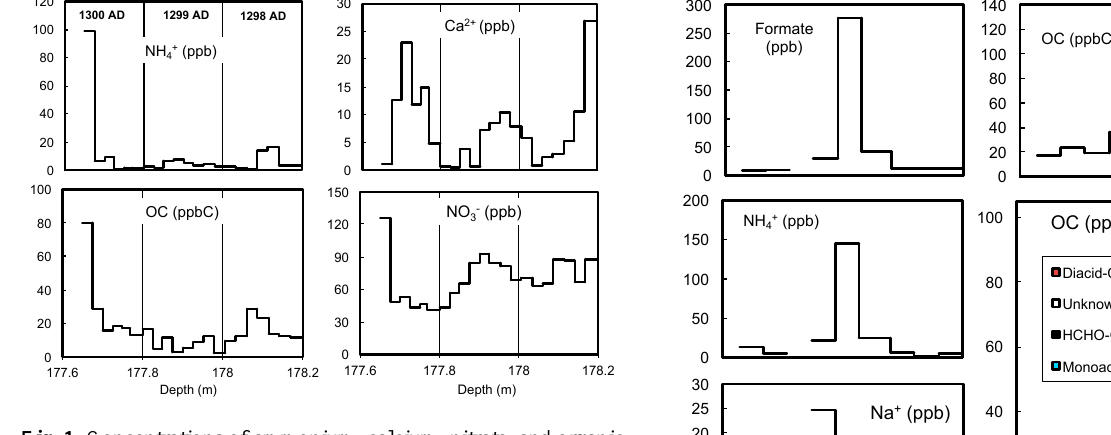
Fig. 1. Concentrations of ammonium, calcium, nitrate, and organic carbon along a 55cm long ice core section extracted at Summit (central Greenland). Vertical lines refer to winter characterized by nitrate and ammonium minima, and sodium maximum (not shown). The calcium maximum is in spring. Note that, except in 1299AD, the OC concentrations are higher in summer than in winter. As dis- cussed in Sect. 3.1, the presence of a high level of OC (DOC or TOC within 10% uncertainty; see Sect. 3.2.1) in summer 1300 AD corresponds to a forest fire event as indicated by the large amount of ammonium and formate present in this layer (see also Fig. 2).